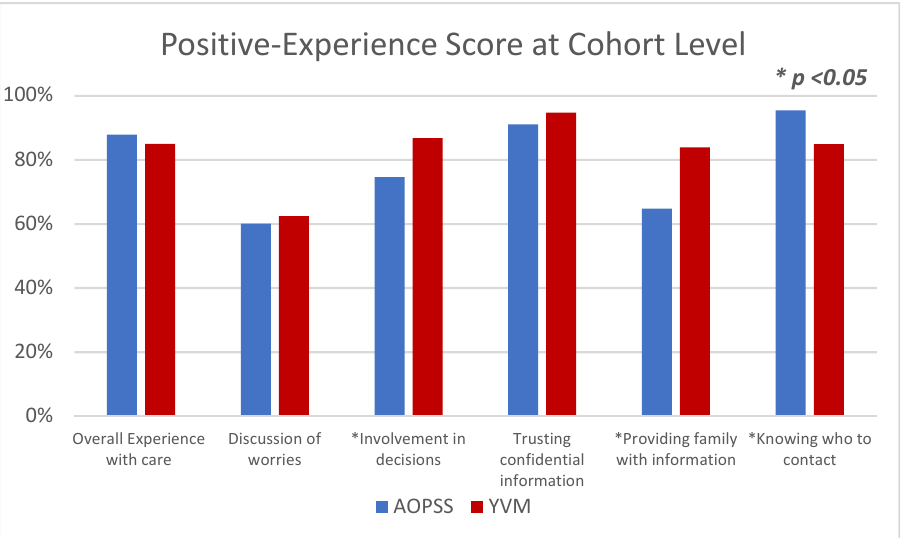
Figure 1. Patient-Reported Experience for the AOPSS and YVM Cohorts. AOPSS, Ambulatory Oncology Patient Satisfaction Survey; YVM, Your Voice Matters. * Represent a statistically significant difference.